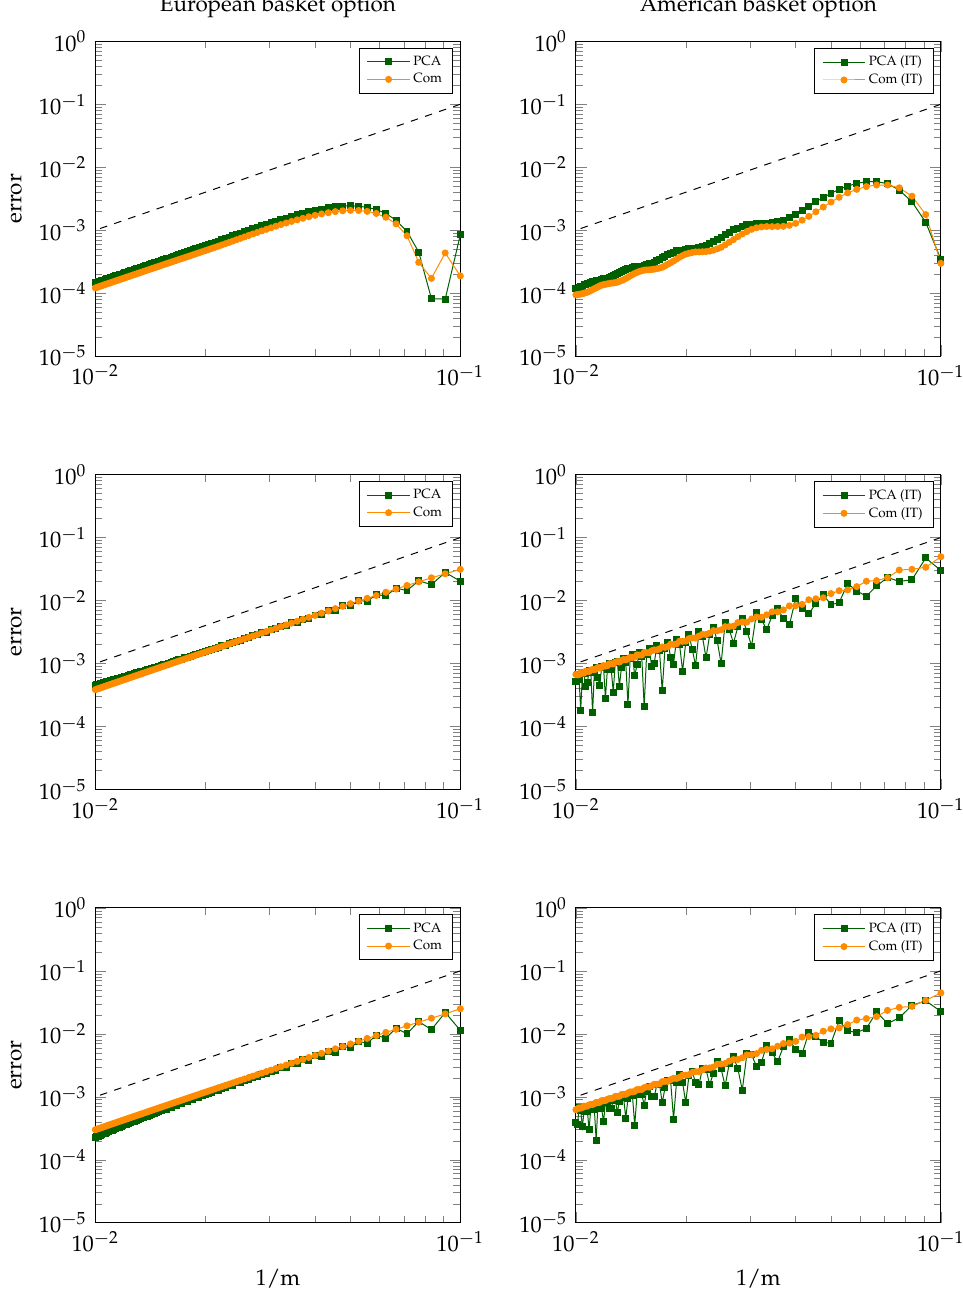
Figure 2. Discretisation error for r u p S 0 , T q and u app p S 0 , T q in cases A ( top ), B ( middle ) and C ( bottom ). Left : European basket option. Right : American basket option. Reference line (dashed) included for second-order